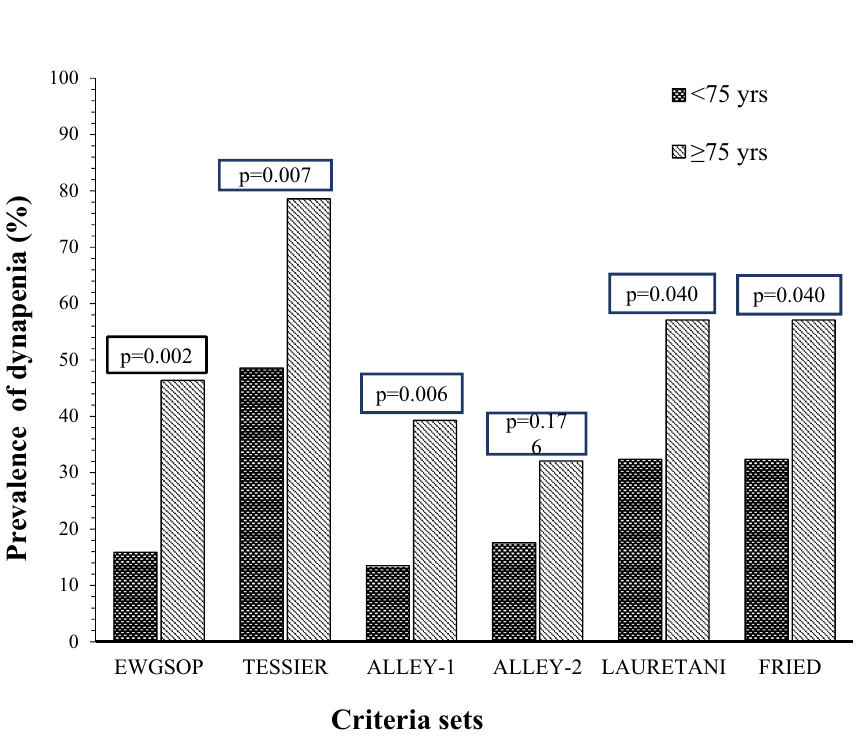
Figure 2. Prevalence of dynapenia (according to different criteria sets) by age groups in the 102 patients with idiopathic pulmonary fibrosis (IPF) participating in the